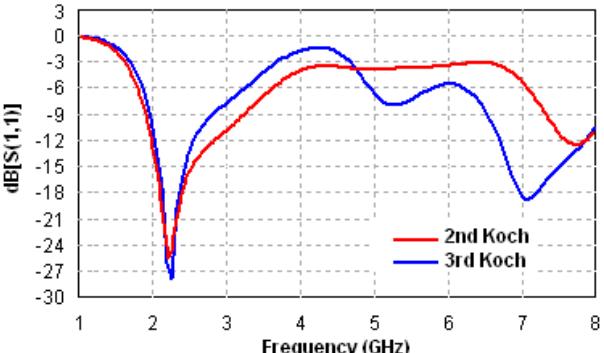
Figure 3: The S 11 responses of the 2nd and the 3rd iteration Koch fractal monopole antennas